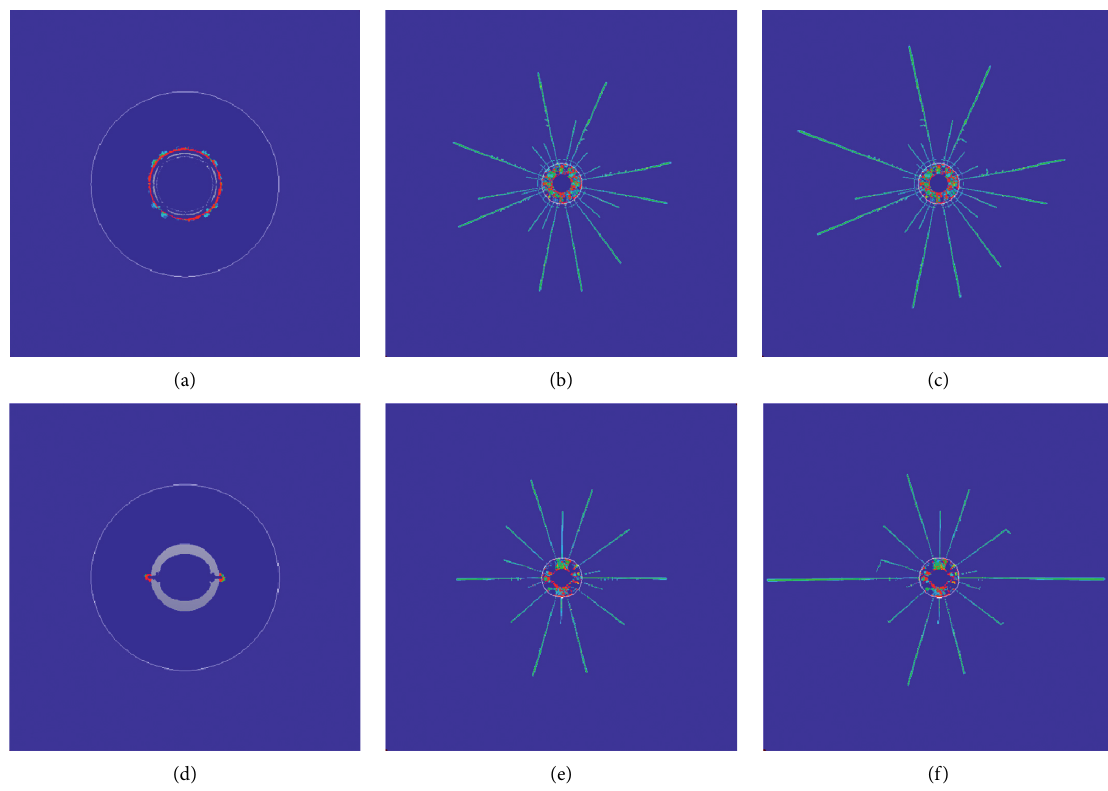
Figure 9: Damage propagation process under single-hole load. (a–c) Ordinary blasting. (d–f) Shaped blasting.